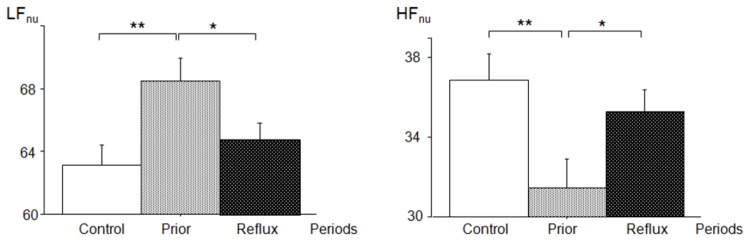
Effect of the period on normalized values (mean ± SEM) of the power spectra in the low- (LFnu) and high-frequency (HFnu) bands.*P<0.05, **P<0.01. (pairwise multiple comparison procedures were used to test the differences between the control, prior and during periods. Data were adjusted for multiple testing with the Tukey-Kramer test).